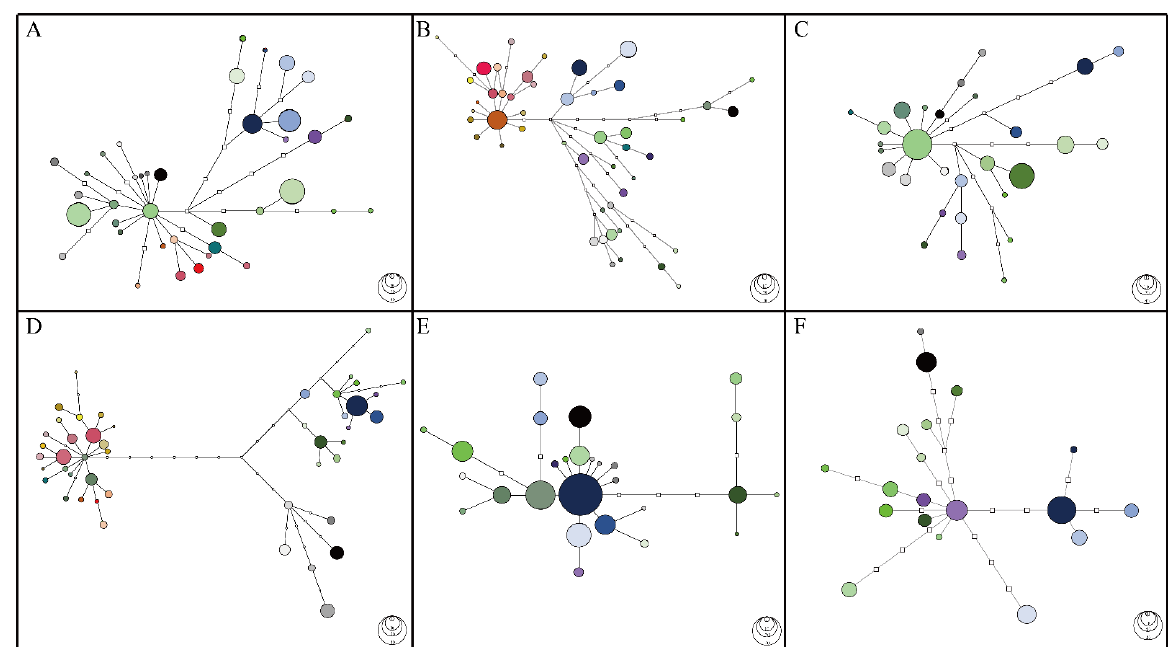
Figure 2. Statistical parsimony networks reconstructed from the six loci isolated from C. ramondioides . Hollow squares indicate hypothetical (i.e., extinct or not sampled) haplotypes; one mutational step is represented as a line connecting to each haplotype. The size of colored circle corresponds to haplotype frequency. ( A ). ATG2 intron 1, ( B ). GroES intron 1, ( C ). LFY intron 1, ( D ). CrCYC1 , ( E ). ITS , and ( F ). cpDNA ( trn L-F + trn H- psb A). Color codes are listed in Supplementary Figure S1. Haplotype and ribotype frequency maps are shown in Supplementary Figure S2.